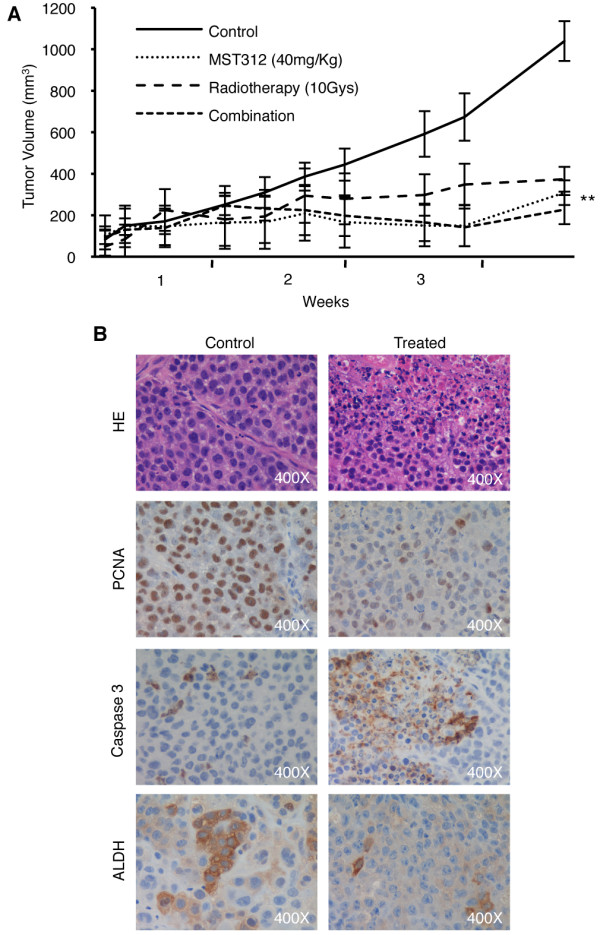
Telomerase inhibition by MST312 reduces tumor growth in vivo. A: Tumor growth shows strong reduction in mice that were treated for 3 weeks with MST312 (40 mg/kg, daily). Radiotherapy alone (10 Gys administrated locally at days 3 and 13) produced a similar effect. No significant improvement was obtained by combination of both therapies. B: H&E of untreated and MST312-treated mice (upper panel) show tumor cells with pyknotic nuclei upon treatment; immunohistochemistry for PCNA and cleaved-caspase 3 (middle panel) demonstrate a reduction in proliferation and increased apoptosis in mice injected with MST312, compared to controls; immunostaining for ALDH (lower panel) also reveals a reduction in the number of labeled cells after administration of the telomerase inhibitor.